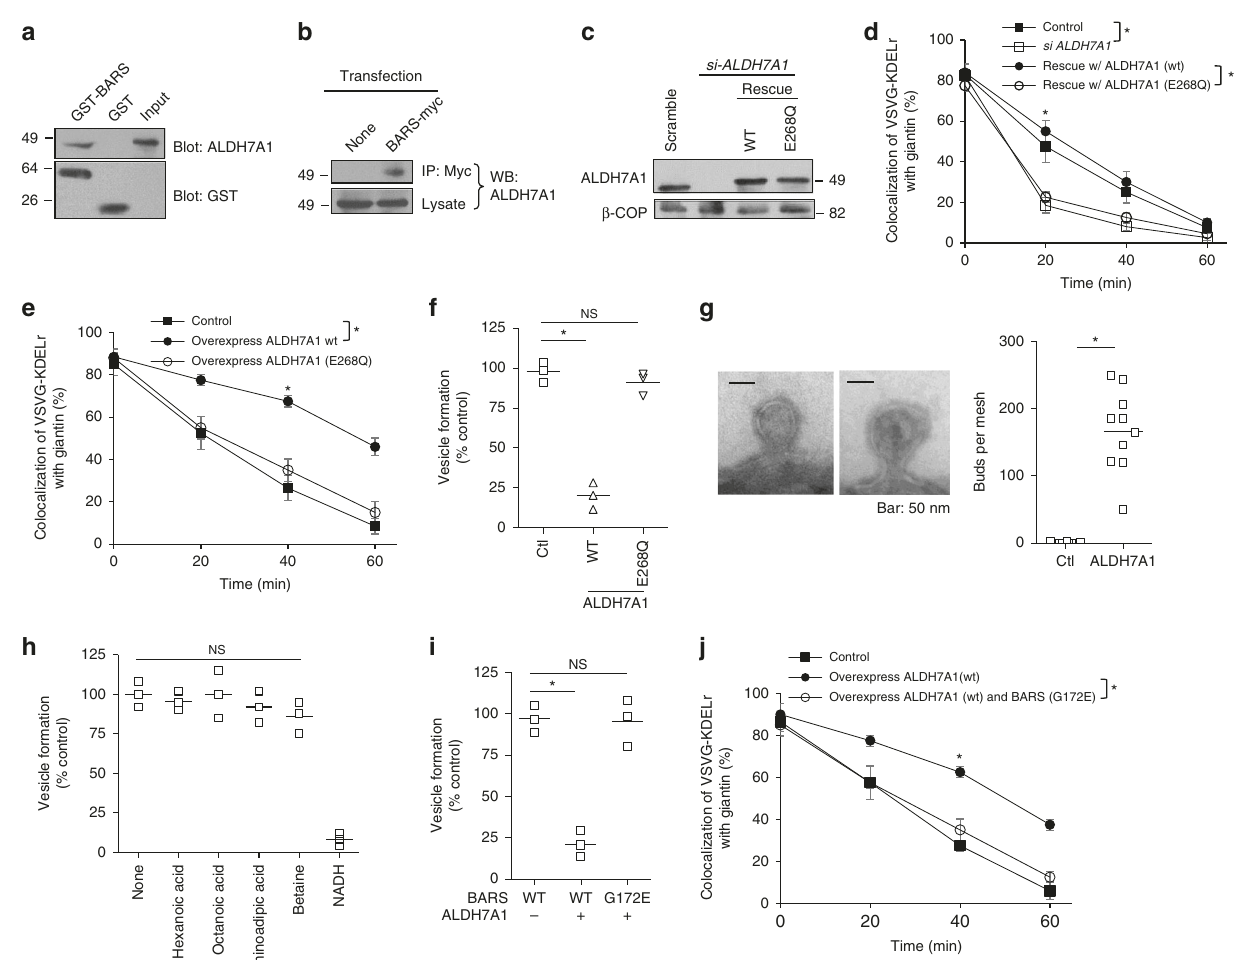
Fig. 1 ALDH7A1 inhibits COPI transport. Quantitative results are shown as mean with standard deviation; * p < 0.05, NS not signi fi cant, paired two-tailed Student ’ s t -test. Source data are provided as a Source Data fi le. a GST – BARS on beads was incubated with recombinant ALDH7A1, followed by immunoblotting with antibodies against indicated proteins; n = 2 independent experiments with a representative result shown. b HeLa cells were transfected with construct as indicated, followed by immunoprecipitation for the myc tag and then immunoblotting for ALDH7A1; n = 2 independent experiments with a representative result shown. c HeLa cells were treated as indicated and then whole-cell lysates were immunoblotted for proteins as indicated; n = 2 independent experiments with a representative result shown. Rescues for siRNA-treated cells were performed using tagged forms of ALDH7A1. d HeLa cells were treated as indicated, and then colocalization of VSVG-KDELR with a cis -Golgi marker (giantin) coupled with kinetic analysis was performed; n = 3 independent experiments. e HeLa cells were treated as indicated, and then colocalization of VSVG-KDELR with a cis -Golgi marker (giantin) coupled with kinetic analysis was performed; n = 3 independent experiments. f The COPI reconstitution system was performed followed by quantitation; n = 3 independent experiments. g Golgi membrane after the incubation in the reconstitution system was examined by EM. Representative images are shown on the left (scale bar, 50 nm), and quantitation is shown on the right; n = 3 independent experiments. h The COPI reconstitution system was performed in the presence of different metabolic products (carboxylates) of ALDH7A1 or NADH; NS not signi fi cant, ANOVA; n = 3